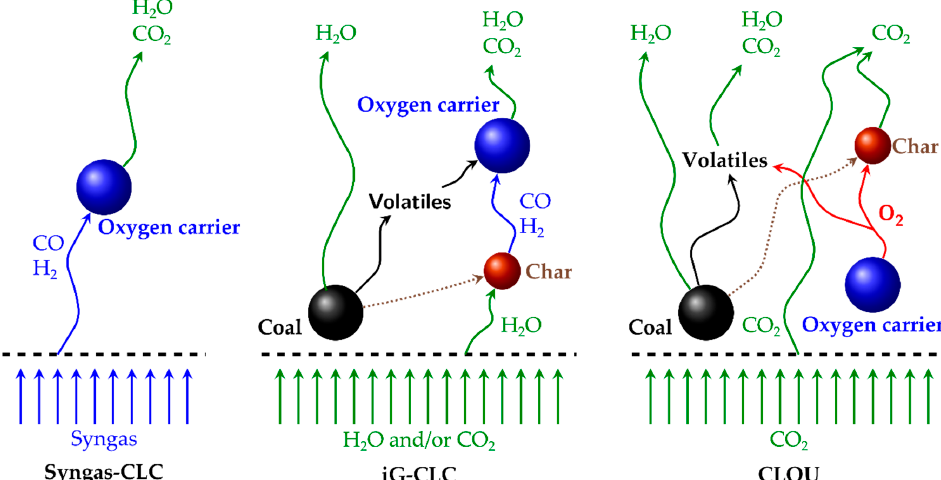
Figure 5. Main reaction mechanisms involved in solid-fuel combustion in the three different chemical